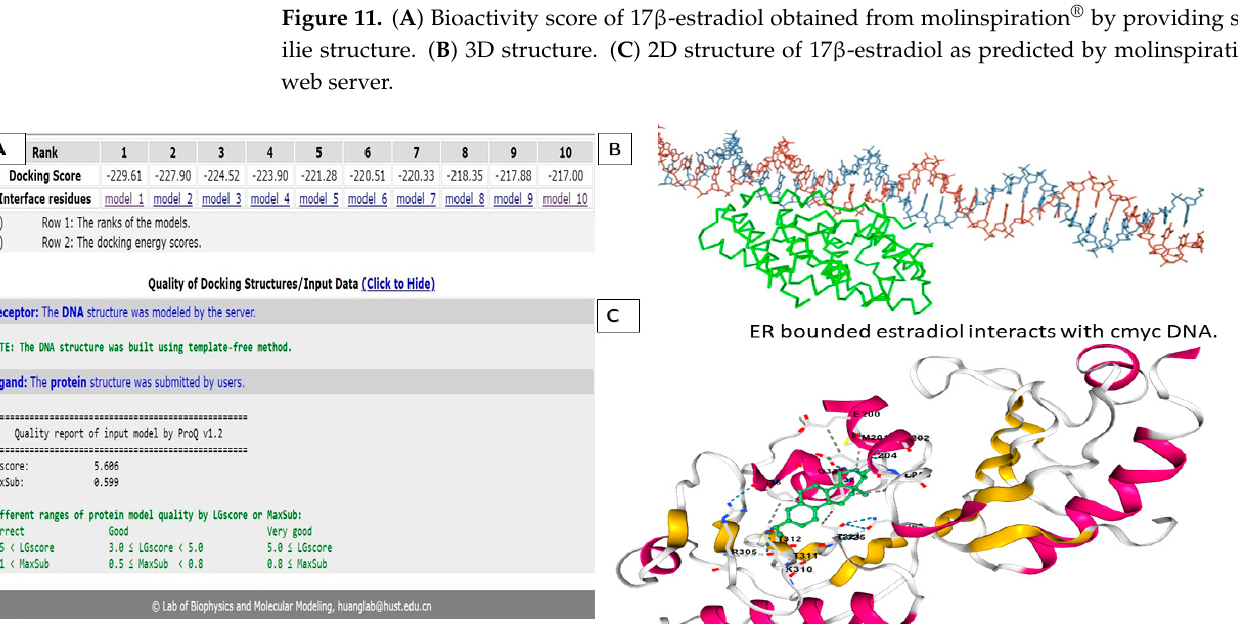
kcal/mol (Model 2 at HDOCK) binding with LG score 5.606 and MaxSub < 0.8. ( C ) estradiol interacts with c-myc protein results available for job 60 ce3ba192bf6.